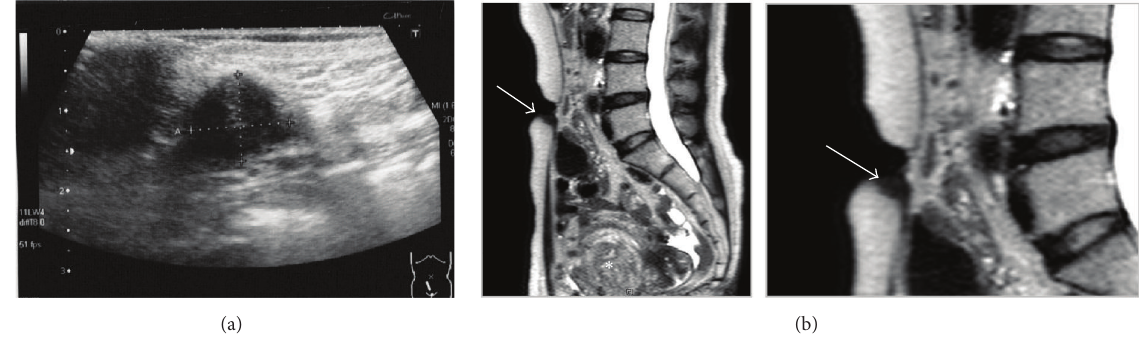
Figure 1: (a) Transcutaneous USG and (b) abdominal MRI (T2-weighted sequence). USG showed 1.0 × 1.5 cm umbilical nodule. MRI also exhibited the hypodense umbilical nodule (arrow) and myoma (asterisk).